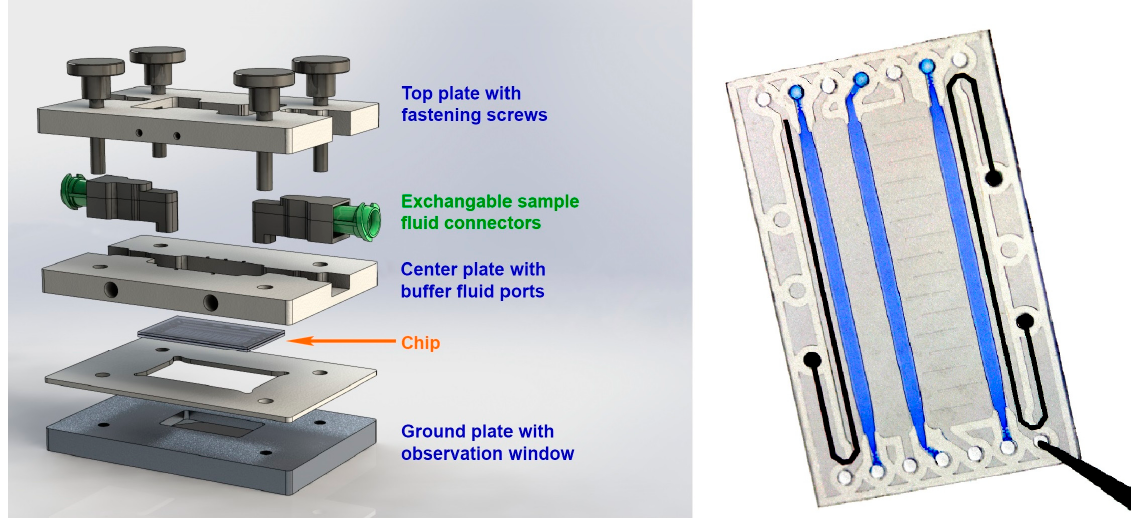
Figure 1. Left : Explosion view rendering of the chip holder used for the experiments. It can be placed on an inverted microscope, with the focus (observation plane) in the center of the sample chamber of the microfluidic glass chip. Right : Photograph of a Chip with hydrogel barriers (blue) and electrode structures